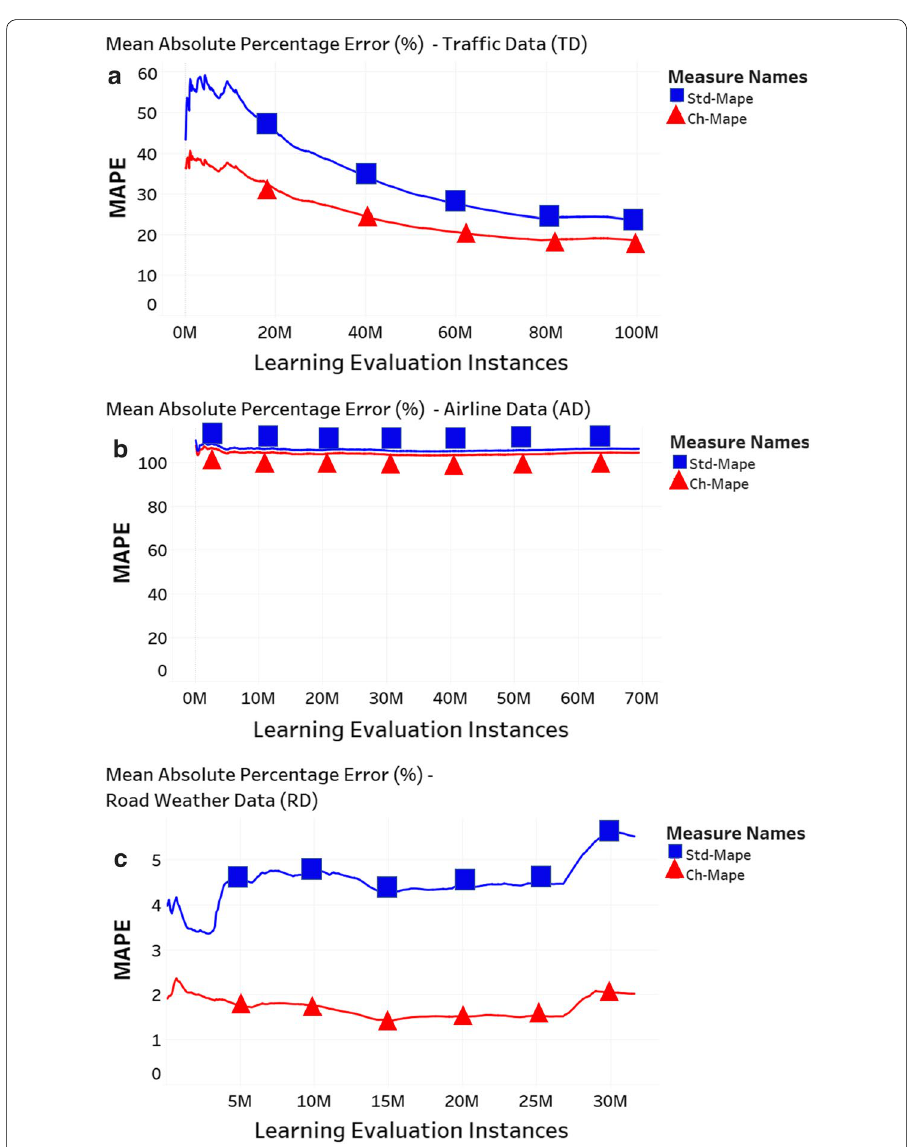
Fig. 4 MAPE value measurement of Hoeffding bound (std-mape) and Chernoff bound